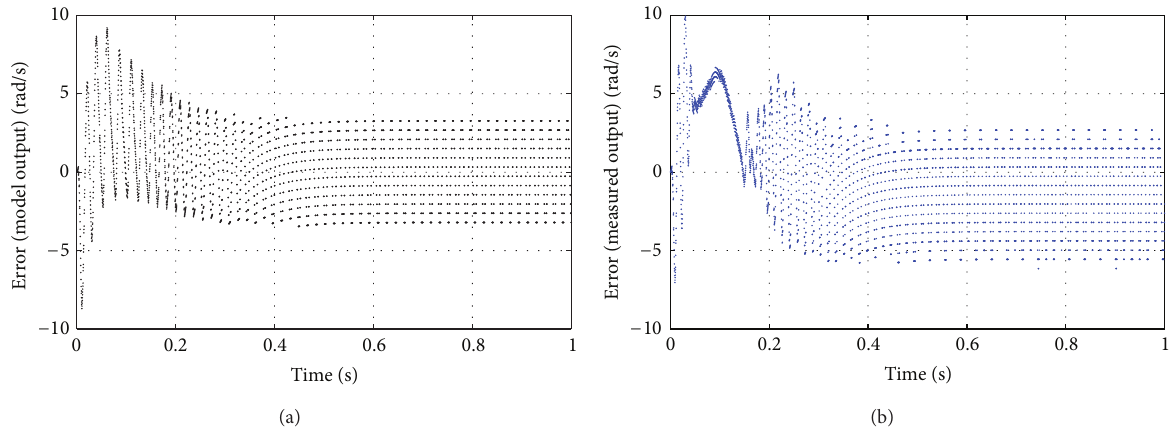
Figure 4: (a) Simulated and (b) experimental results for the tracking error when 𝑊 𝑚